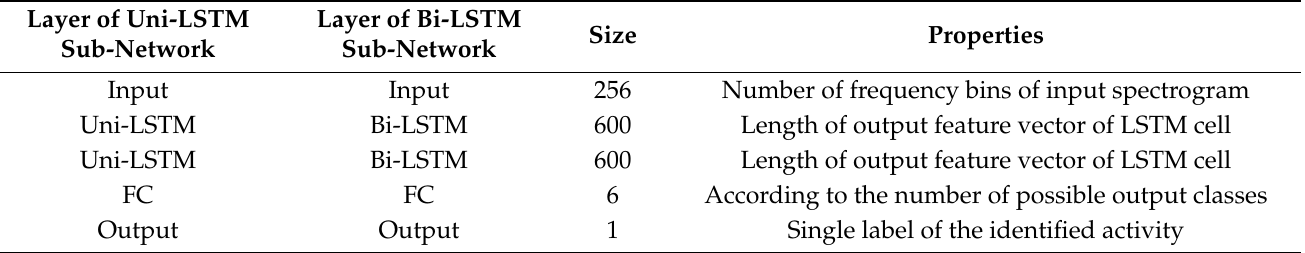
Table 1. Parameters and properties of Uni-LSTM sub-network and Bi-LSTM sub-network. Layer of Uni-LSTM Layer of Bi-LSTM Size Sub-Network Sub-Network